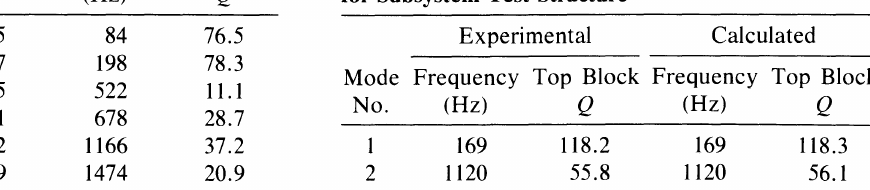
for Subsystem Test Structure Experimental